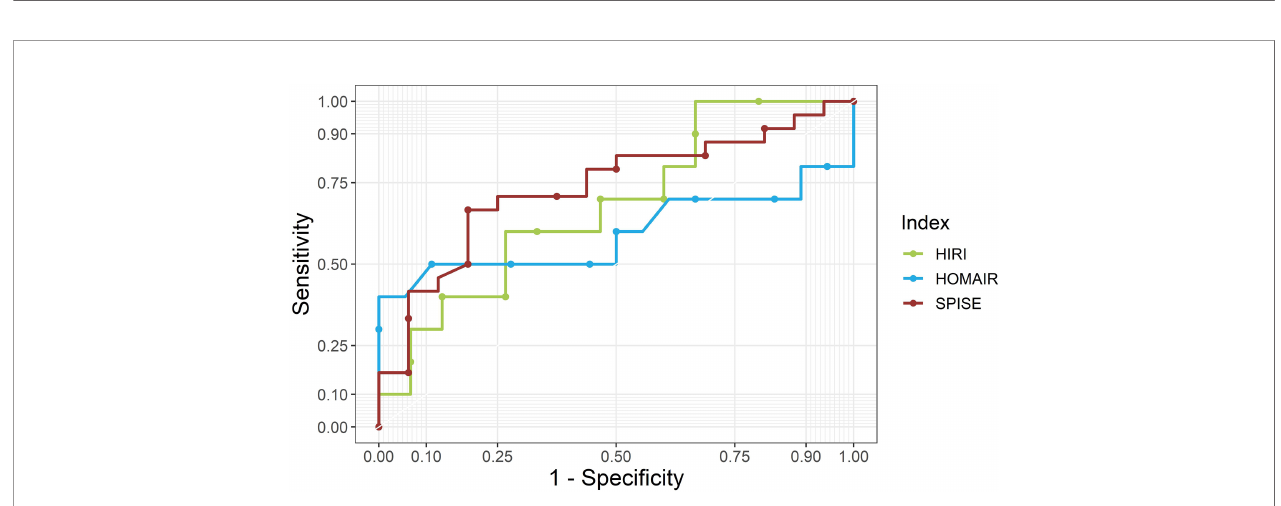
FIGURE 3 | ROC curves for SPISE, HOMA-IR and HIRI for female patients. SPISE, Single Point Insulin Sensitivity Estimator; HOMA-IR, homeostatic Model Assessment for Insulin Resistance; HIRI, Hepatic Insulin Resistence